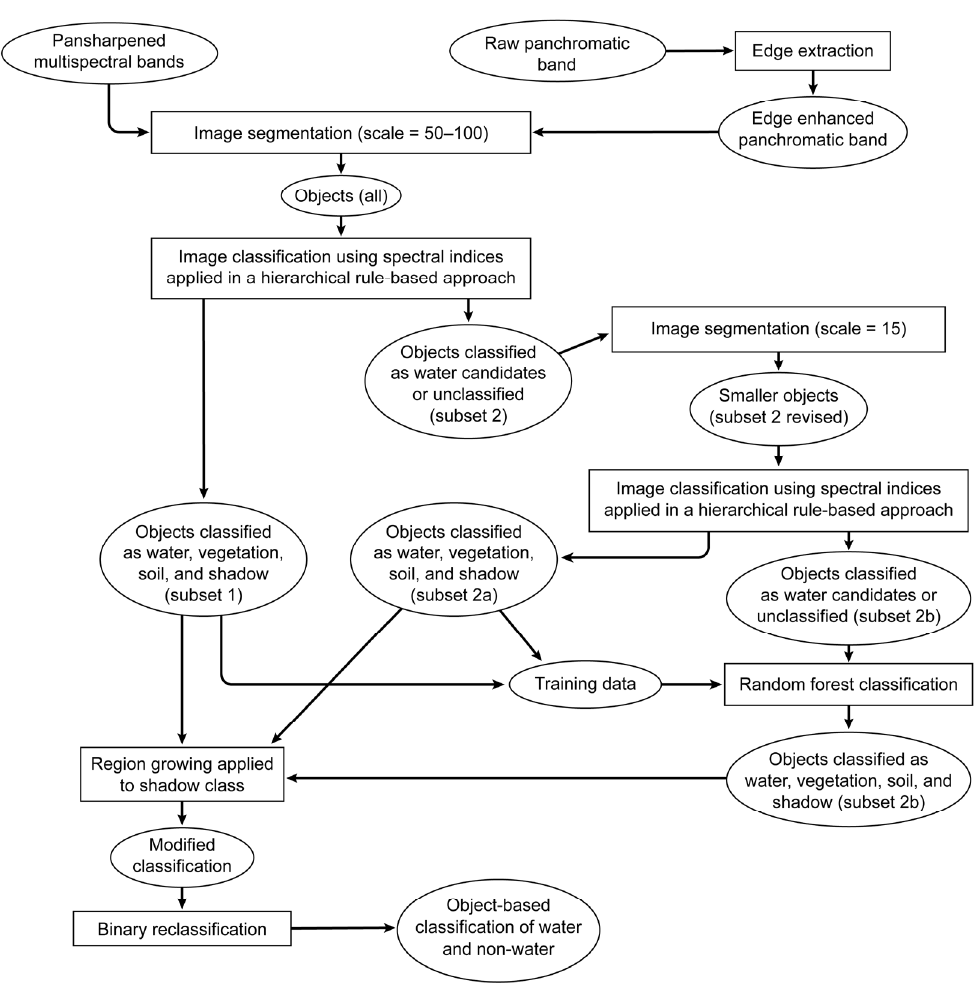
Figure 5. A flowchart showing the order of steps taken to process each image to water and non ‐ water using an object ‐ based approach. Inputs and outputs are shown in ovals while processing steps are shown in rectangles.